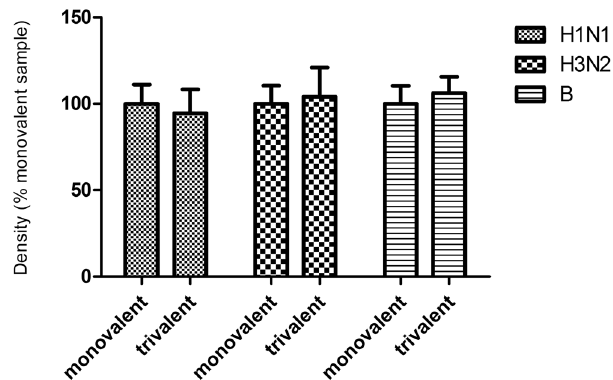
Figure 4. Specificity and interference of NA slot-blot. Samples were diluted to final concentration of HA 2 μ g/ ml (trivalent samples contain 2 μ g/ml HA from each strain). Each sample was tested in six replicates. The NA contents of trivalent samples were normalized and reported as percentage of monovalent